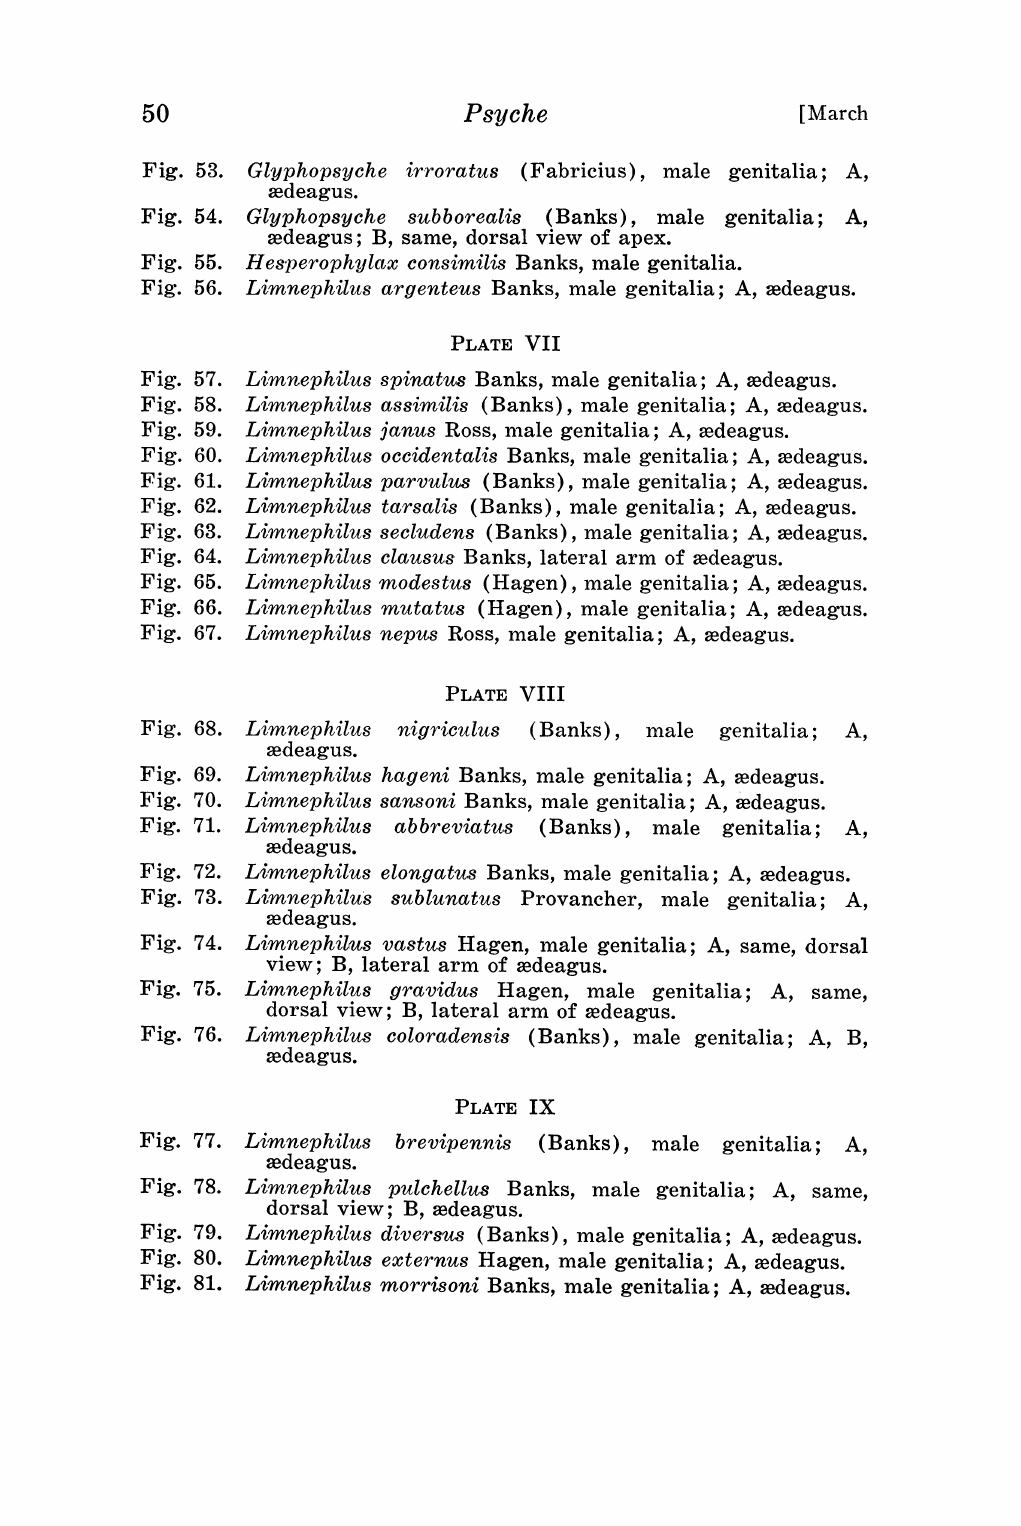
Glyphopsyche irroratus (Fabricius), male genitalia; A, mdeagus. Glyphopsyche subborealis (Banks), male genitalia; A, mdeagus; B, same, dorsal view of apex. Hesperophylax consimilis Banks, male genitalia. Limnephilus argenteus Banks, male genitalia; A, mdeagus.